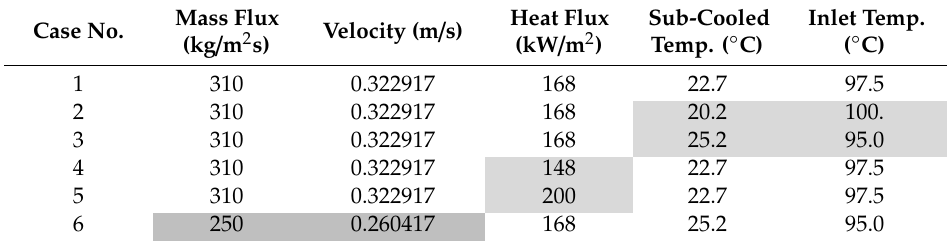
Table 2. Initial conditions of six cases.